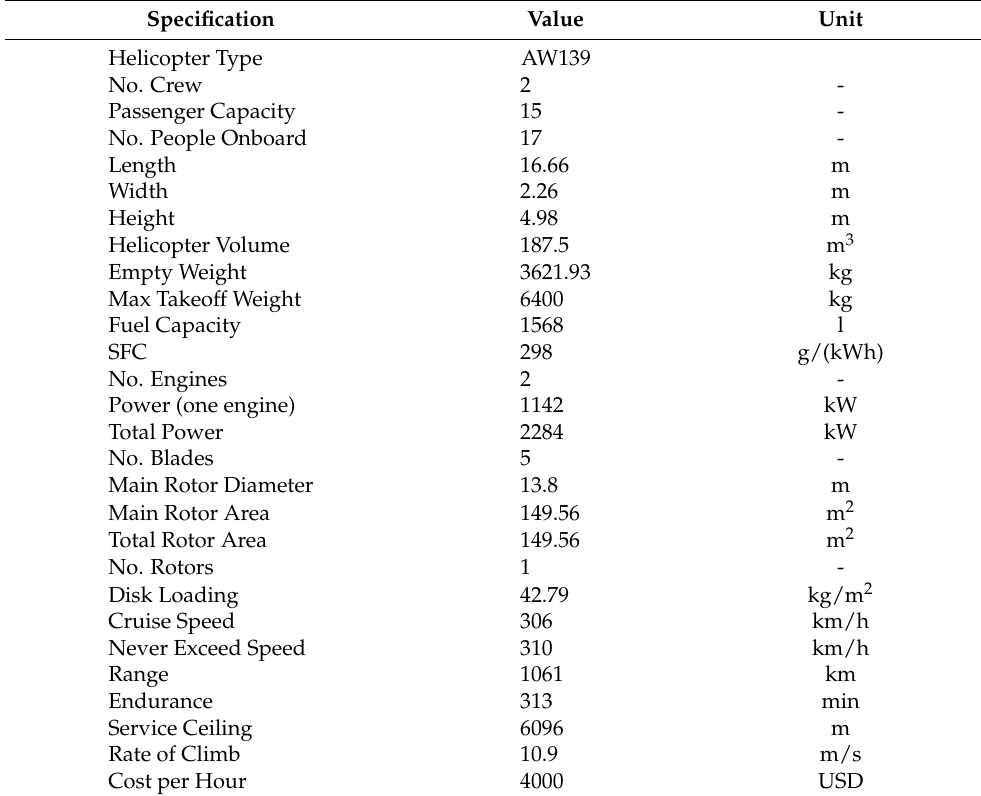
Table 1. The different specifications that were collected. An AW139 helicopter is included as a reference to show its values and the associated